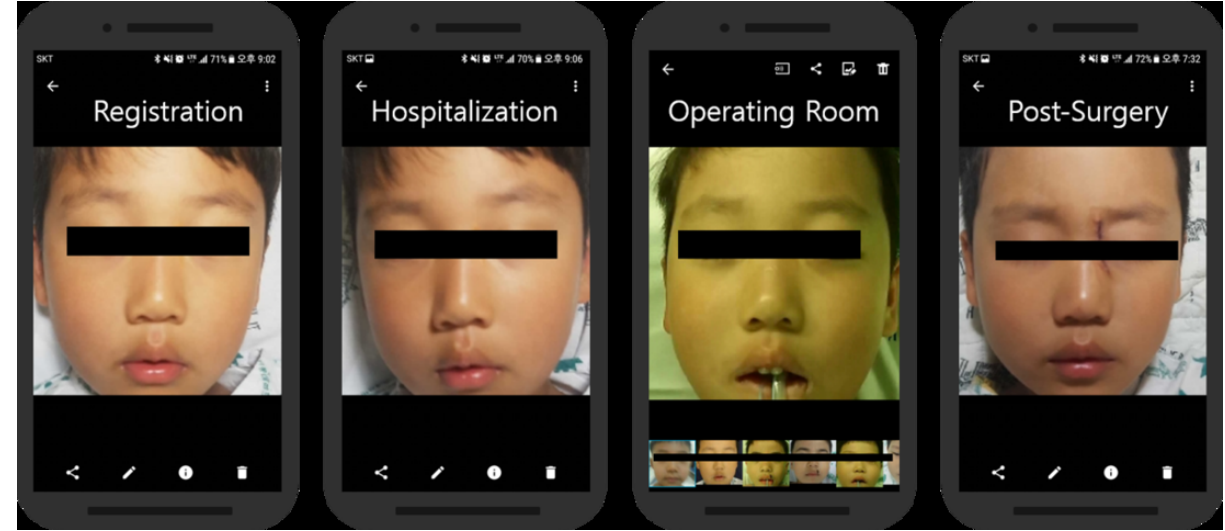
Figure 7. Verified inpatient's input images in various